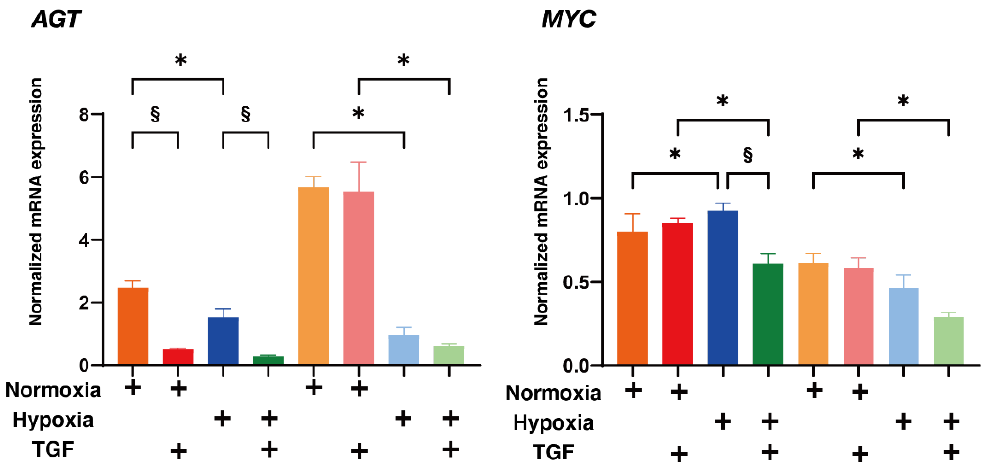
Figure 9. Effects of TGF- β 2 on mRNA expression of the possible up-stream regulators of 3D spheroids; STAT3 , IL6 , FOS , TGFb1 , AGT and MYC of 2D and 3D HRPE cells under normoxia or hypoxia conditions. Two-dimensional and three-dimensional cultured HRPE cells at Day 6 prepared under normoxia or hypoxia conditions were treated without (control) or with a 5 ng/mL solution of TGF- β 2 (TGF β ), and each sample was subjected to qPCR analysis and the expression of mRNA in the possible up-stream regulators requiring for the generation of the 3D spheroids [36]; STAT3 , IL6 , FOS , TGFb1 , AGT and MYC , were estimated. All experiments were performed in duplicate using fresh preparations (2D; n = 5, 3D; n = 10 spheroids each). “+” is reagents addition. Data are presented as the arithmetic mean ± the standard error of the mean (SEM). * p < 0.05 control vs. TGF, § p < 0.05 normoxia vs. hypoxia (ANOVA followed by a Tukey’s multiple comparison test).